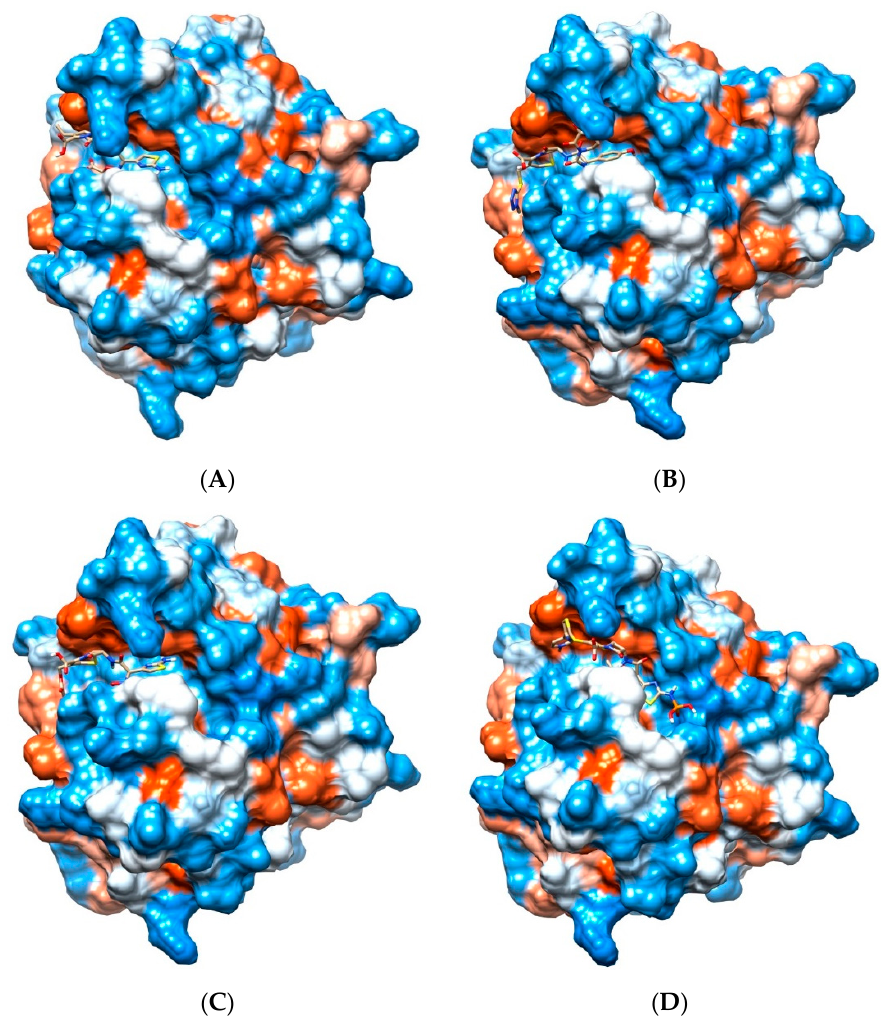
Figure 3. Cephalosporins and Pth1. Depicted is the hydrophobic surface of E. coli Pth1 (PDB 2PTH) with lowest-energy docked poses of select Cephalosporins. Polar regions are in blue, hydrophobic in red. In the binding cavity are the lowest energy conformations of ( A ) Cefixime, ( B ) Cefoperazone, ( C ) Cefotaxime, and ( D ) Ceftaroline fosamil.